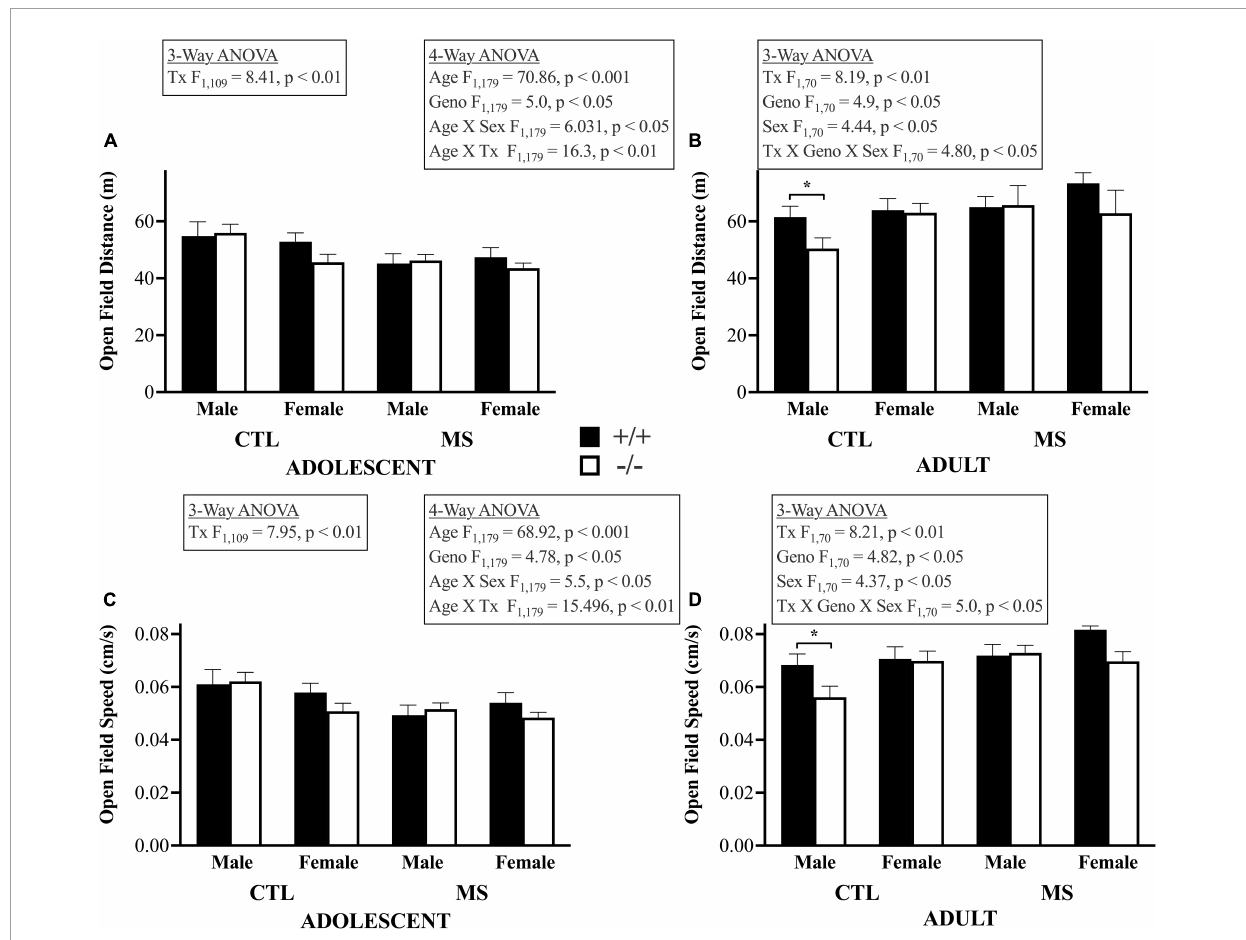
FIGURE3 Locomotor distance and speed in the open field apparatus: bars depict means and SEM for Adolescent (A,C) and Adult (B,D) male and female, control (CTL) or maternally separated (MS) mice of both genotypes. Panels (A,B) show distance traveled in m during the 15 min test. The 4-way ANOVA demonstrated substantial changes in open field activity over time. These were dependent up sex and pup treatment, larger in female and maternally separated subjects. This was followed up by separate 3-way ANOVAs in each age group. In young mice, maternally separated mice were less active than controls. This pattern was also evident in adults, where there was also genotype (+/+ > − / − ) and sex differences (F > M). Finally, in adults, a 3-way interaction demonstrated that the effect of maternal separation on distance traveled depended upon both sex and genotype. Panels (C,D) show a similar pattern with respect to the speed of locomotor activity in the Open Field Apparatus. There were main effects of Age, with adults quicker than adolescents. This was truer in females with β -E. Asterisks highlight significant post hoc differences. Group sizes ranged from 7 to 17, please see Table 1 for details. All significant group differences are highlighted in the textboxes. Please see the text for the complete